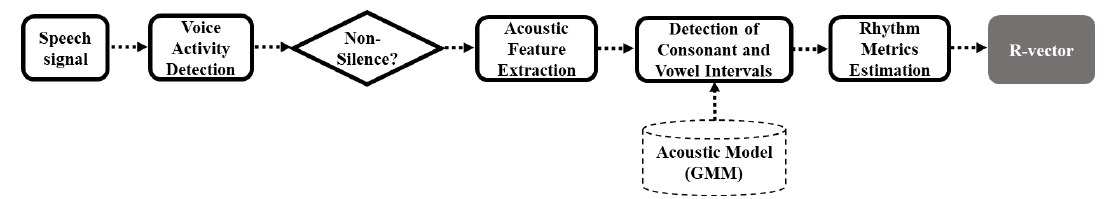
Figure 1. Overall procedure of the automatic extraction of rhythm metrics.